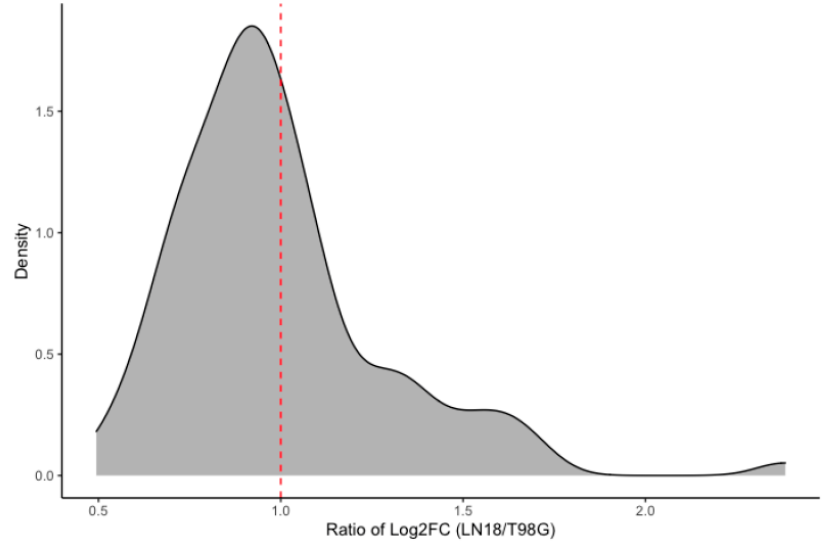
Figure 3. Ratio plot showing the intersection of genes that are differentially expressed in both macrophages treated with LN-18 supernatants and macrophages treated with T98G supernatants. Plotted on the x -axis is the ratio of log2FC in macrophages treated with LN-18 supernatants divided by the log2FC in macrophages treated with T98G supernatants. Plotted on the y -axis is the density (or number) of genes. Higher numbers of genes (density) falling below 1.0 indicate mutually expressed genes that are more highly differentially expressed in T98G-treated as compared to LN-18-treated THP-1 macrophages. Relatively lower densities falling above 1.0 indicate mutually expressed genes that are more highly DGE in LN-18-treated compared to T98G-treated THP-1 macrophages. Genes relevant to M1-like or M2-like macrophage genotype were selected post-DGE analysis for further consideration. LN-18 and T98G secretions showed similar effects on M2-like gene expression in THP-1 macrophages (Figure 4A,B). Both GBM cell lines caused